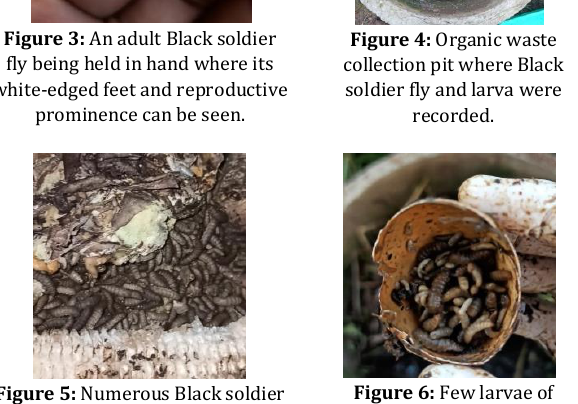
Figure 5: Numerous Black soldier fly larvae feeding on organic waste as seen on the waste bin